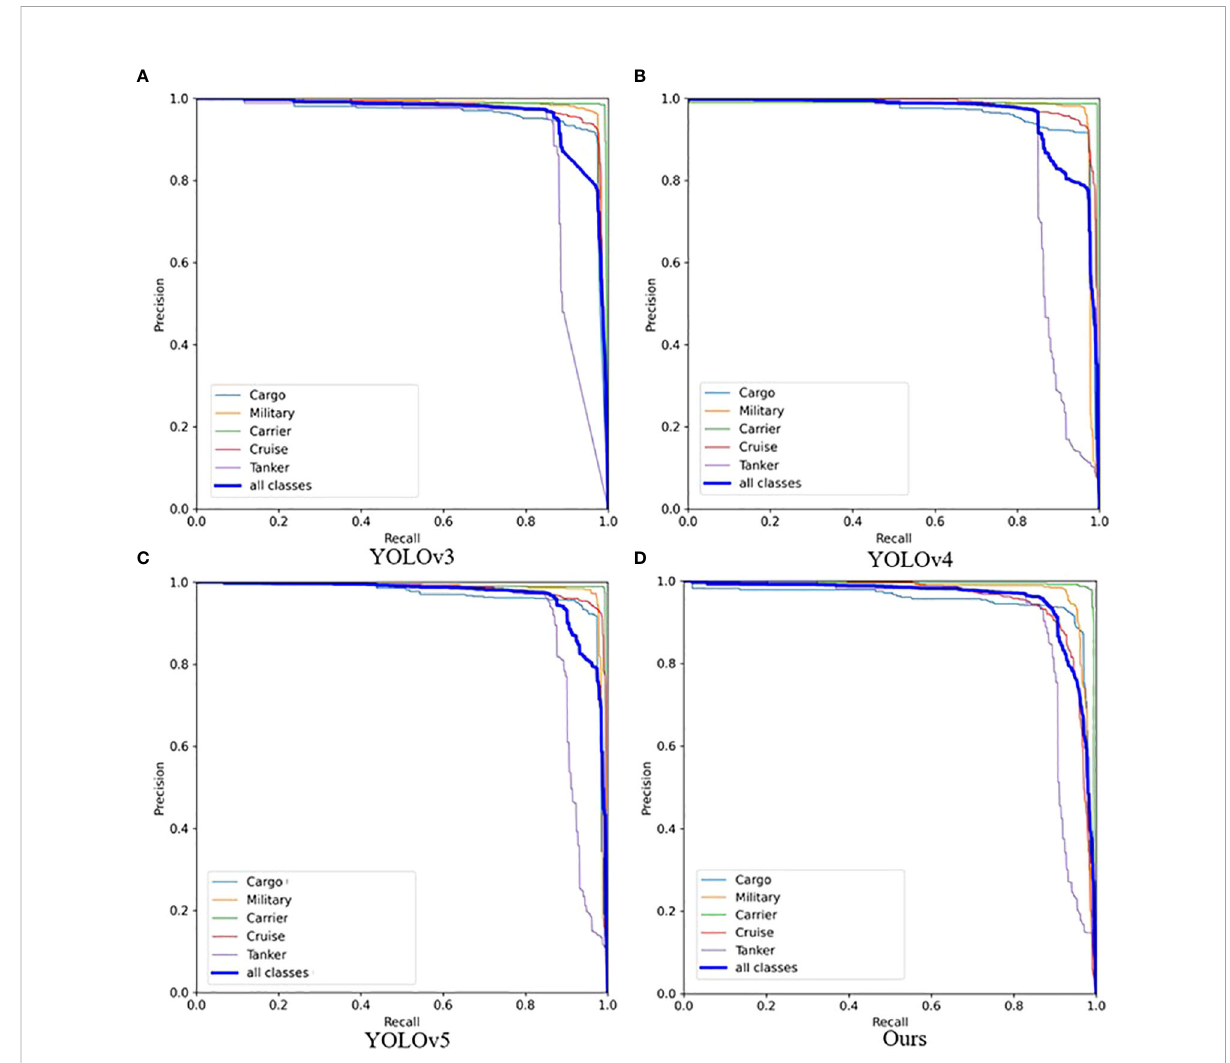
FIGURE 9 Precision-Recall (P-R) curves of different object detection algorithms on the ship dataset (IoU = 0.5). (A) is from YOLOv3, (B) is from YOLOv4, (C) is from YOLOv5 and (D) is from our proposed